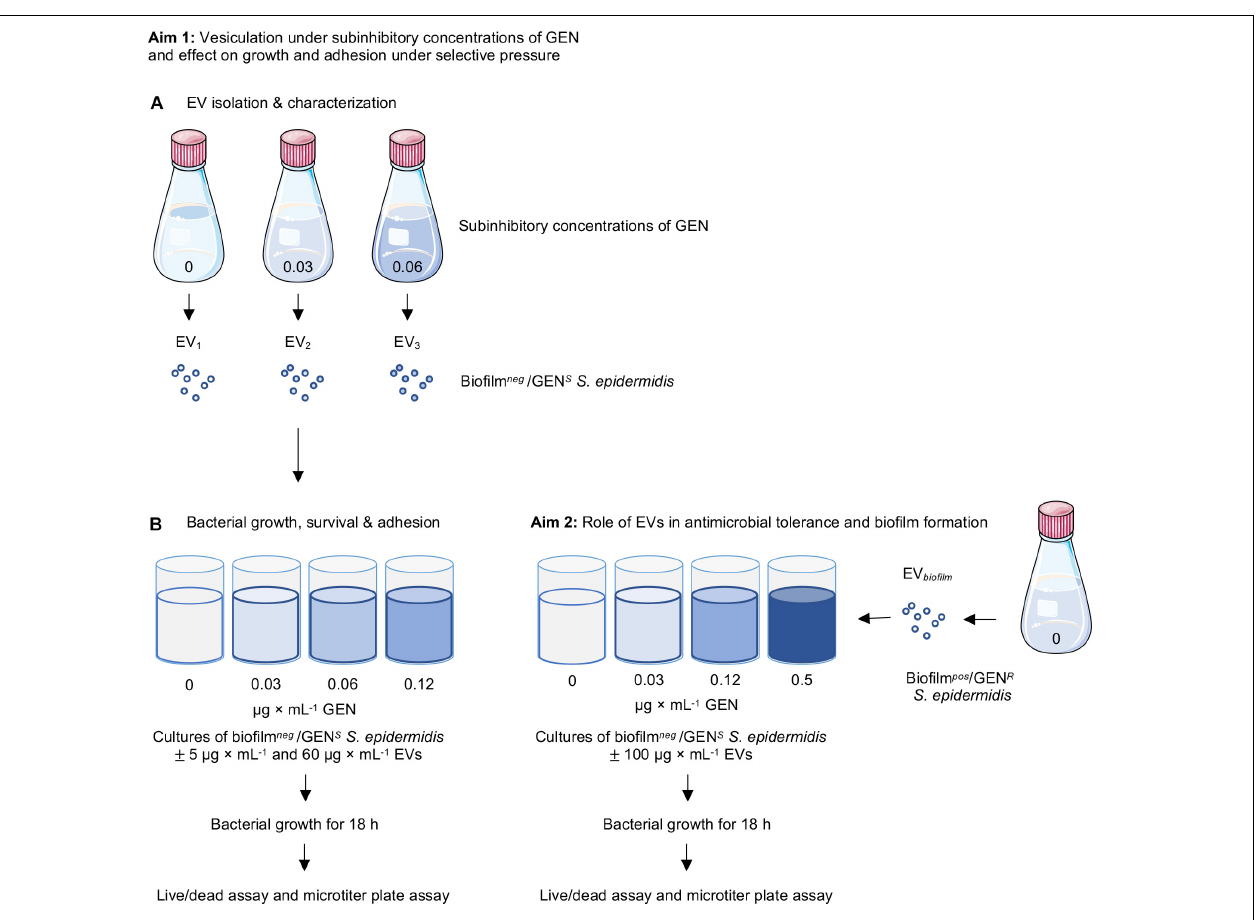
FIGURE 1 | Schematic figure of the experimental system. (A) EVs were isolated from non-biofilm-producing Staphylococcus epidermidis CCUG 64523 under different culture conditions with and without supplementation of gentamicin (0, 0.03, and 0.06 µ g × mL − 1 ). Kinetic growth curves of S. epidermidis CCUG 64523 with and without gentamicin supplementation (0, 0.03, 0.06, and 0.12 µ g × mL − 1 ) and with and without stimulation of the three EV types isolated (EV 1 , EV 2 , and EV 3 ) were generated. Live/dead fluorescence and microtiter plate assays were performed after 18 h of culture to analyze the effect of EVs on planktonic growth and adherence of bacterial cells to tissue culture plates. (B) EVs isolated from the biofilm-producing, gentamycin-resistant strain S. epidermidis ATCC35984 were added to cultures of S. epidermidis CCUG 64523 with and without gentamicin supplementation (0, 0.03, 0.12, and 0.5 µ g × mL − 1 ), and kinetic growth curves were generated. Live/dead and microtiter plate assays were performed after 18 h of culture to analyze the effect of EVs on planktonic viability and the adherence of bacterial cells to tissue culture